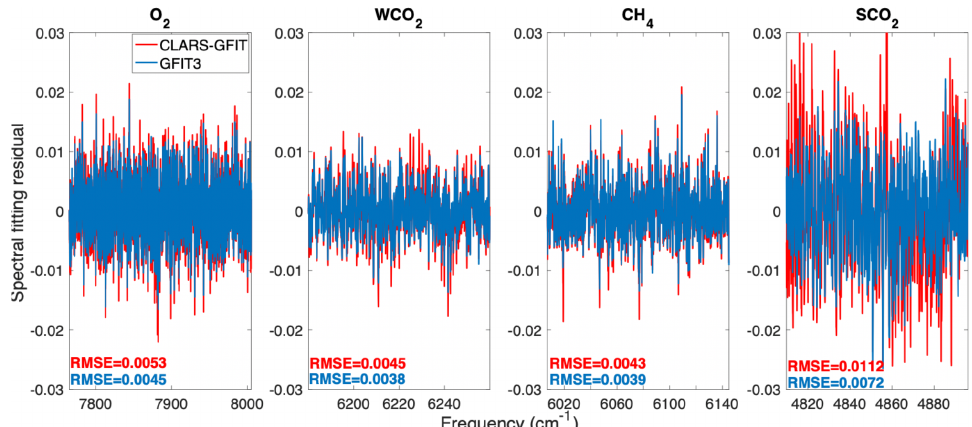
Figure A3. Example of spectral fitting residuals from the CLARS-GFIT (red; ignoring aerosol scattering) and GFIT3 (blue; accounting for aerosol scattering) algorithms for the O 2 , WCO 2 , CH 4 , and SCO 2 spectral windows. The spectral fitting RMSEs are also indicated. This example is for an observation over the West Pasadena surface target on 28 September 2013 with a solar zenith angle of 65 ◦ .